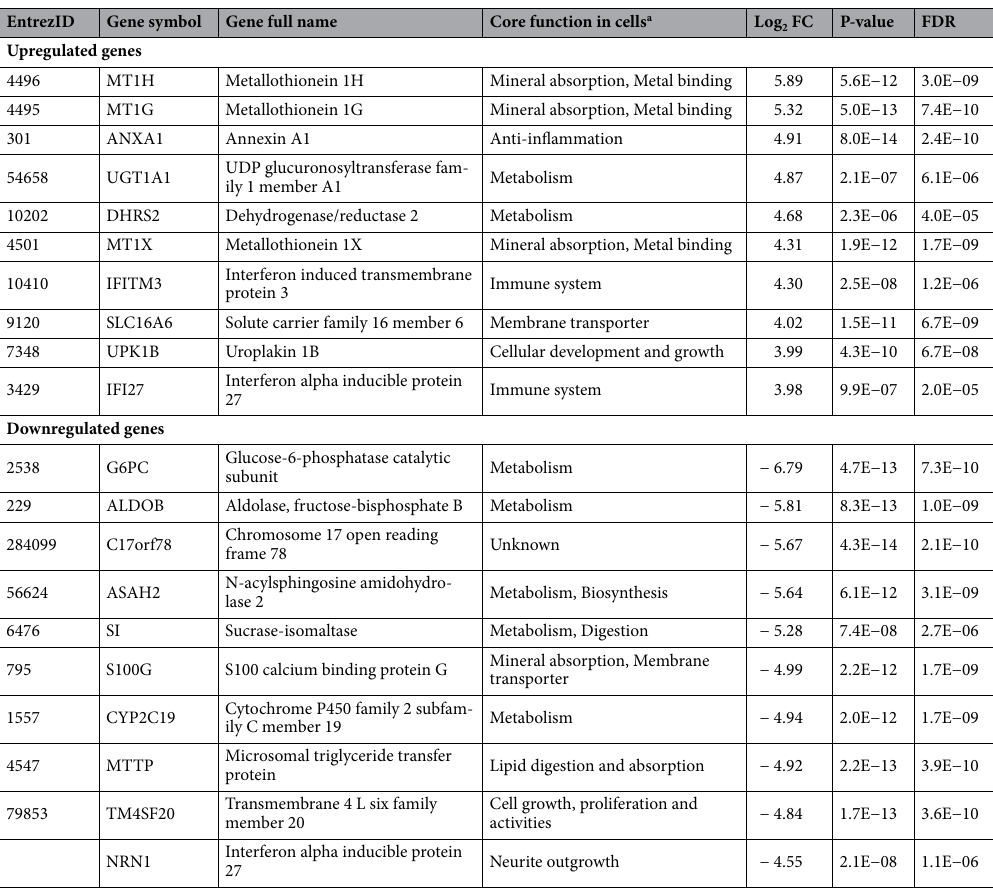
Table 1. Top 10 most up- and downregulated genes in Caco-2 cells cultured under dynamic conditions compared to static conditions after 21 days of culture. a References on the gene functions are provided in Supplementary Table